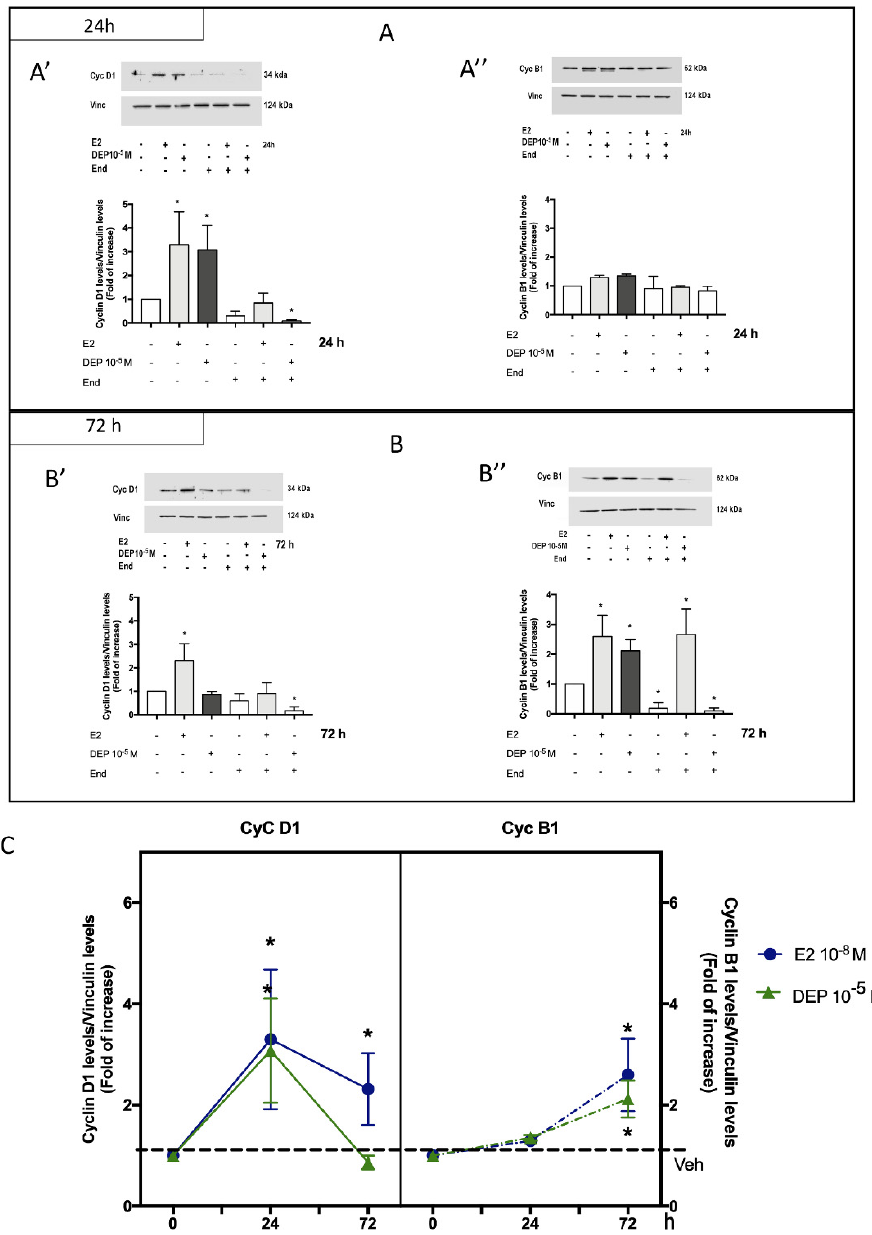
Figure 3. ER α -dependent effect of DEP on cyclin expression. MCF-7 cells were treated with DEP 10 − 5 M for 24 h ( A ) or 72 h ( B ) in the presence or absence of End (10 − 6 M, 1 h before) pre-stimulation, and the protein expression levels of cyclin D1 (Cyc D1; A’ , B’ ) and cyclin B1 (Cyc B1; A’’ , B’’ ) were evaluated by Western blot. Data show representative Western blot images of at least four experiments ( upper panels ) and the corresponding densitometric analysis ( bottom panels ). E2 with or without End pre-treatment was used as positive control. Analysis of expression of cyclin D1 ( left box ) and cyclin B1 ( right box ) as a function of the time of DEP 10 − 5 M exposure ( C ). The level of vinculin was used for protein normalization. Data are means ± SD of at least four experiments. p < 0.01 was determined by the ANOVA test followed by the Bonferroni post-test vs. Veh (-,-,-) (*).